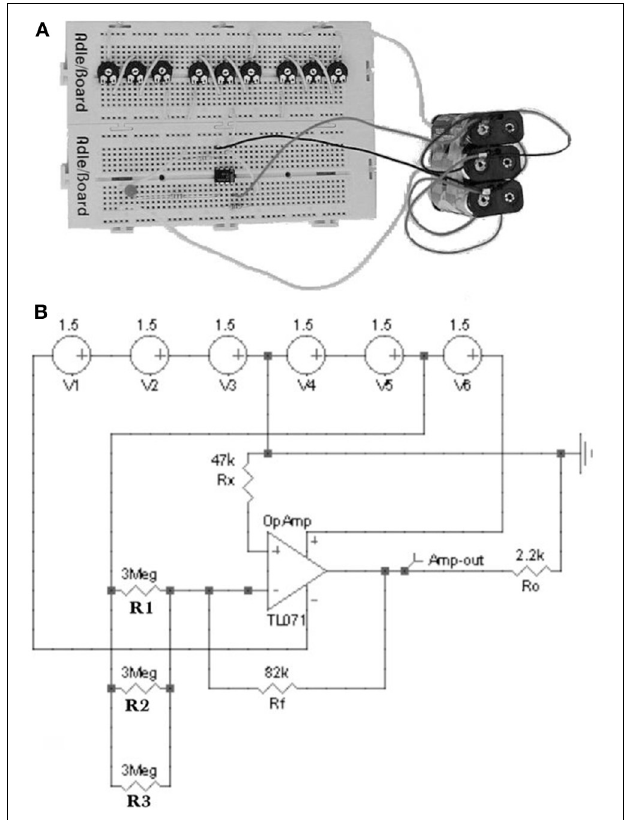
FIGURE 2 | (A) Hardware and (B) software operational amplifier circuits with three repellent inputs. A voltage of + 3V is applied to the potentiometers while the amplifier is powered with + 9V ( + 4.5 and − 4.5V). In the hardware circuit (A) a LED diode connected to the amplifier output detects the intensity of the device signal. In the software circuit (B) a virtual voltage probe replaces to the LED diode (Di Paola et al.,